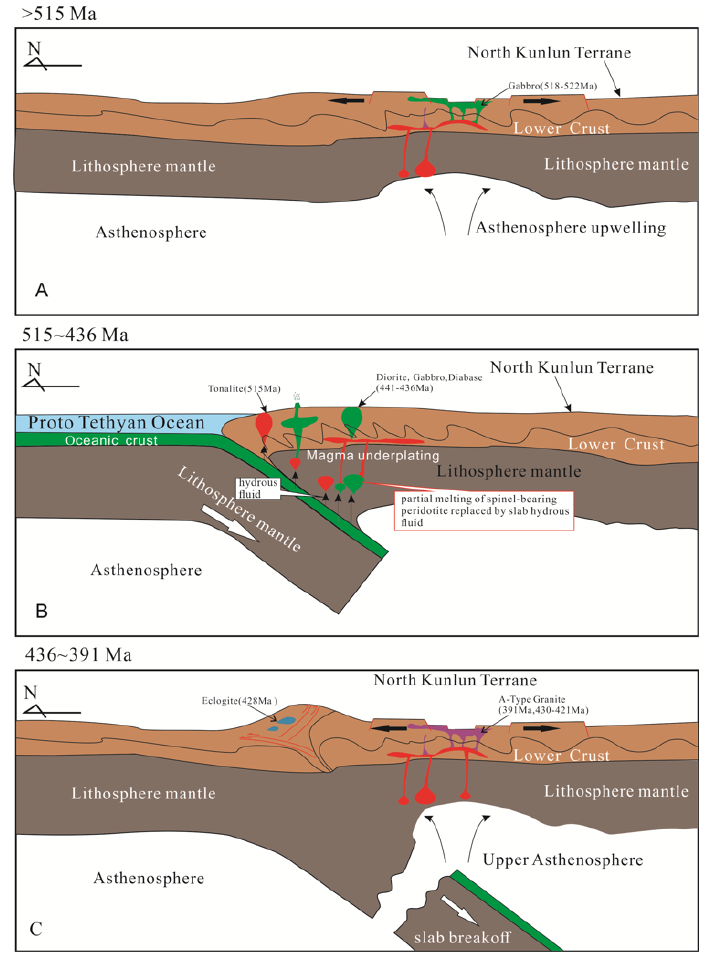
Figure 13. Summary of early Paleozoic magmatic, metamorphic, and tectonic evolution of the Eastern Kunlun Orogen. ( A ) from the Early Cambrian to the Early Ordovician, the existence of an early Paleozoic ocean was identified; ( B ) two studies [91,92] have also shown that mafic rocks, which formed during the postcollision extension period, tend to have a similar geochemical composition to island arc basalt because they inherited mantle source areas modified by paleoslab subduction; ( C ) the magmatic rocks between 430 Ma and 391 Ma are mainly A-type granites, peraluminous–strong peraluminous granites [57], magnesia-rich diorite, and gabbro. Data originate from the literature [1,14,15].